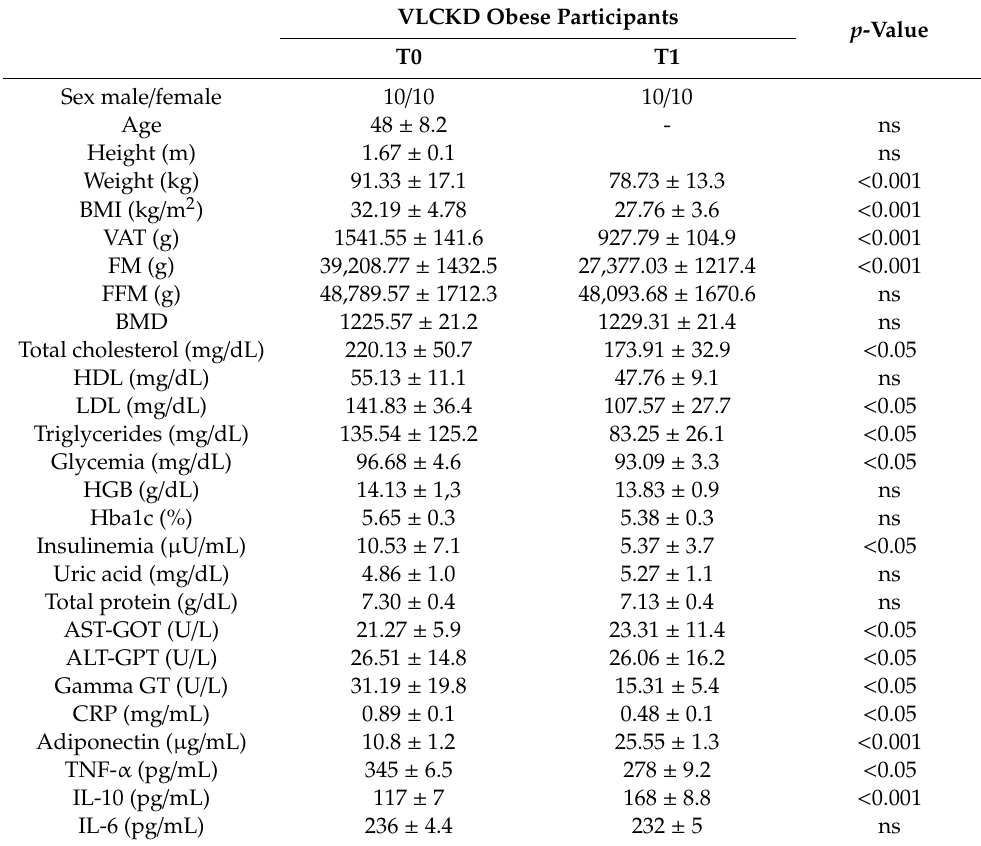
Table 1. Body composition and biochemical features of very low-calorie ketogenic diet (VLCKD) of participants before and after weight-loss.